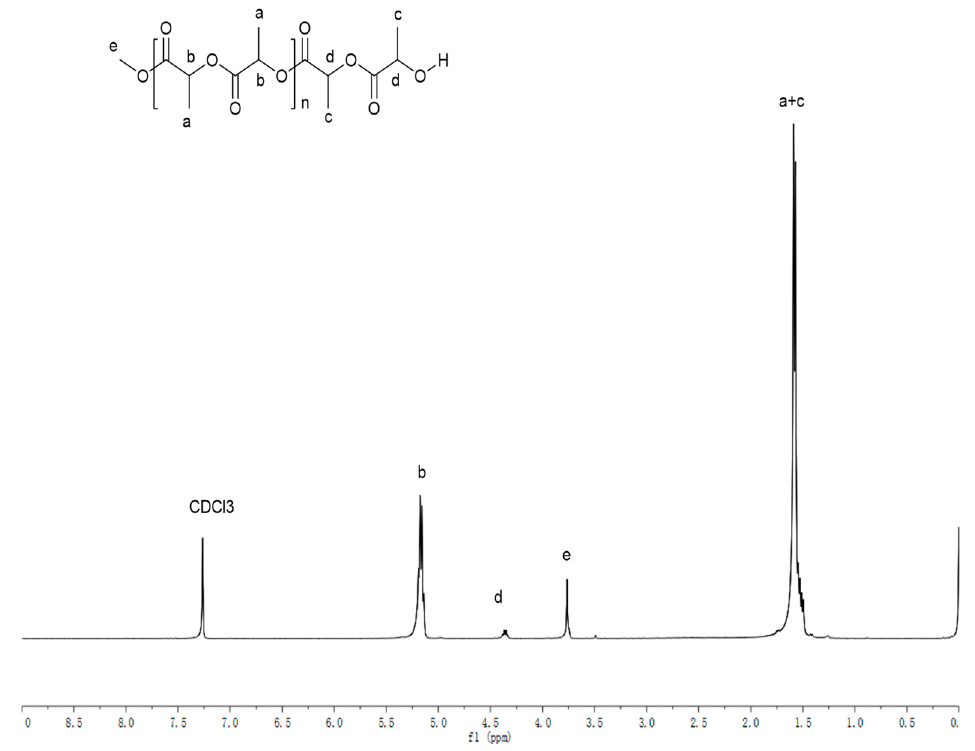
Figure 4. 1 H NMR spectrum of polylactide prepared by the ROP of L -LA (run 6, Table 2).